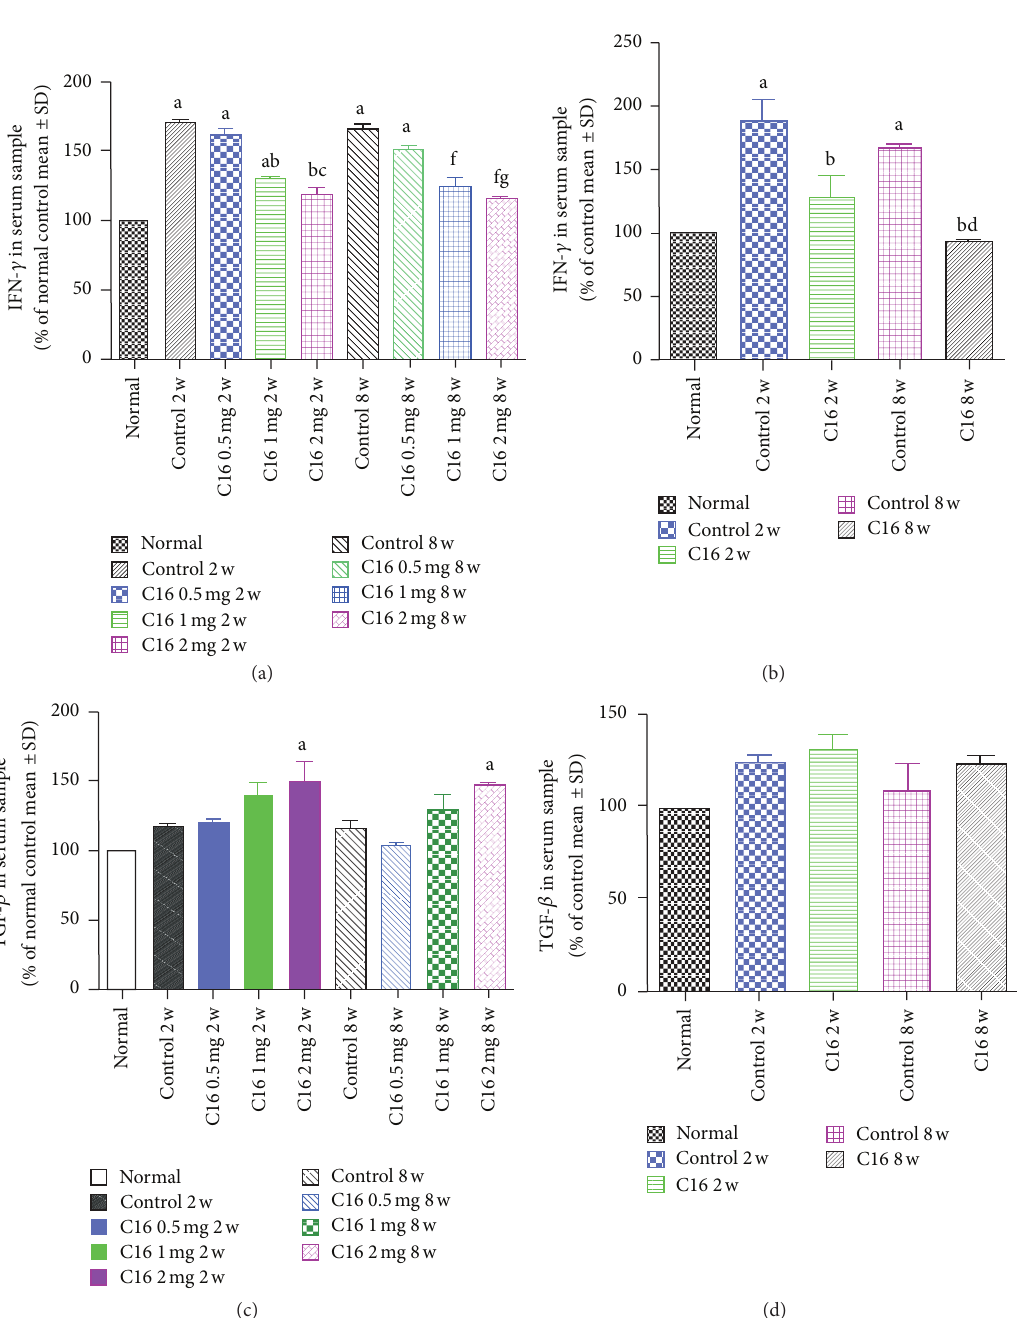
Figure 15: (a) The IFN- 𝛾 levels in plasma samples measured by ELISA in different dose C16 treated groups. a 𝑃 < 0.05 versus normal rats, b 𝑃 < 0.05 versus vehicle control rats, and c 𝑃 < 0.05 versus 0.5 mg/per day C16 treated EAE rats at 2 weeks after immunization. f 𝑃 < 0.05 versus vehicle control rats; g 𝑃 < 0.05 versus 0.5 mg/per day C16 treated EAE rats at 8 weeks after immunization. (a) The IFN- 𝛾 levels in plasma samples measured by ELISA in C16 late treated group. a 𝑃 < 0.05 versus normal rats; b 𝑃 < 0.05 versus vehicle control rats; c 𝑃 < 0.05 versus 0.5 mg/per day C16 treated EAE rats; d 𝑃 < 0.05 versus 1mg/per day C16 treated EAE rats at 8 weeks after immunization. (c) The TGF- 𝛽 levels in plasma samples measured by ELISA in different dose C16 treated group. a 𝑃 < 0.05 versus normal rats. (d) The TGF- 𝛽 levels in plasma samples measured by ELISA in C16 late treated